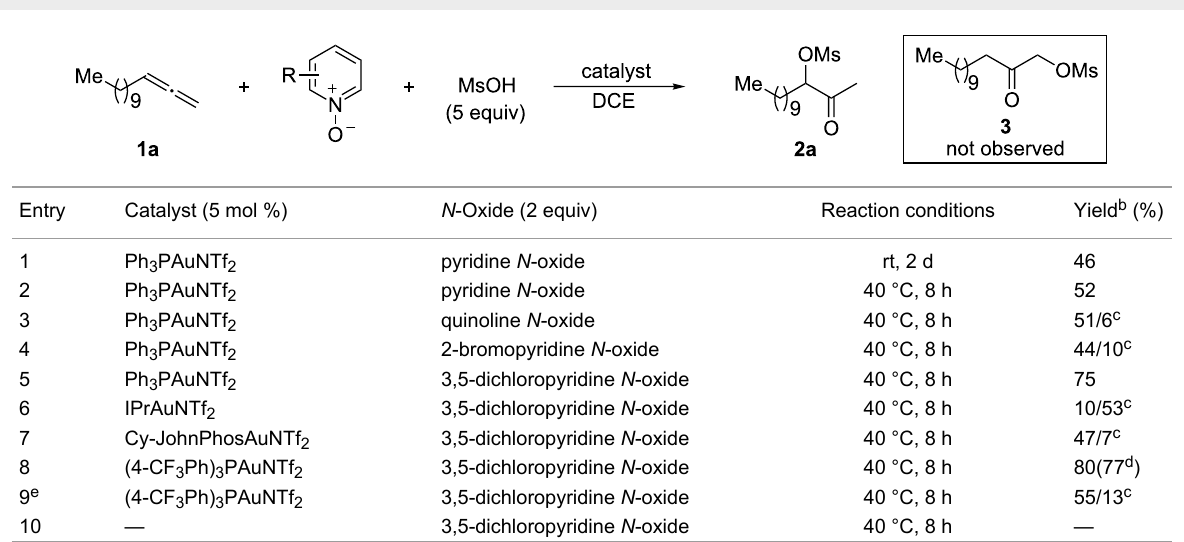
Table 1: Initial studies and condition optimization a